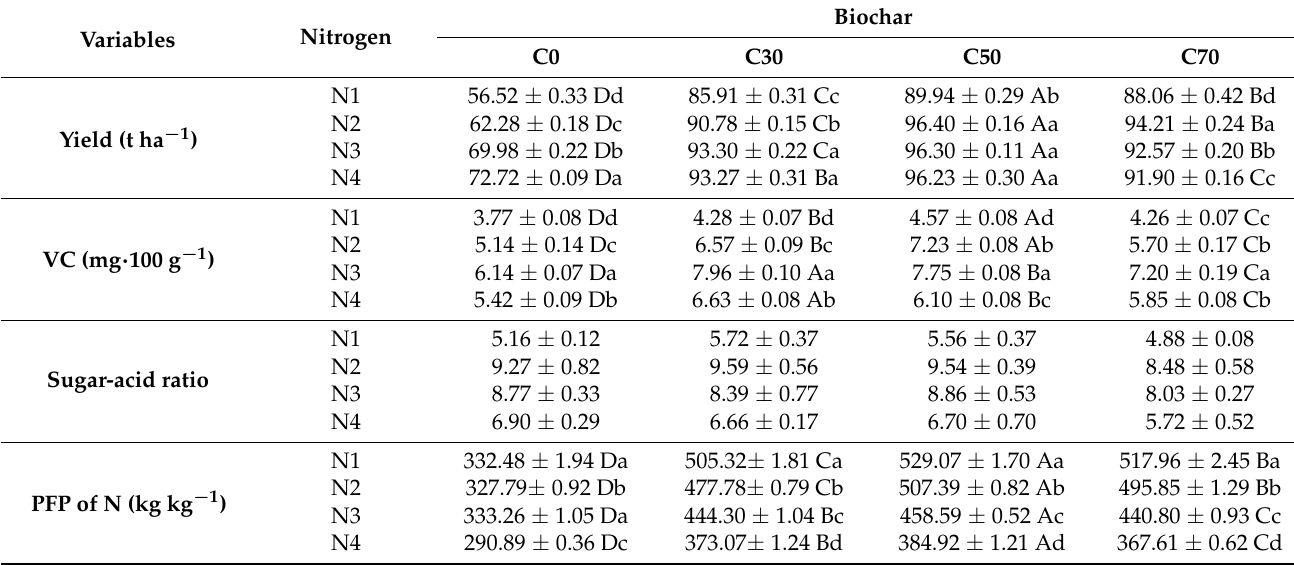
Table 6. Descriptive statistics of tomato yield, sugar-acid ratio, VC, and PFP of N as affected by N (N1, N2, N3, N4) and biochar (C0, C30, C50, C70); each value is the mean value of three replicates ± standard